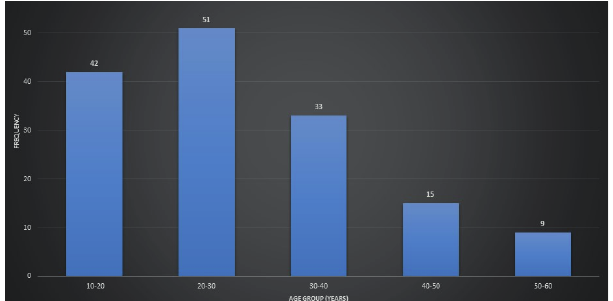
Figure 1. Age-wise distribution of study population.